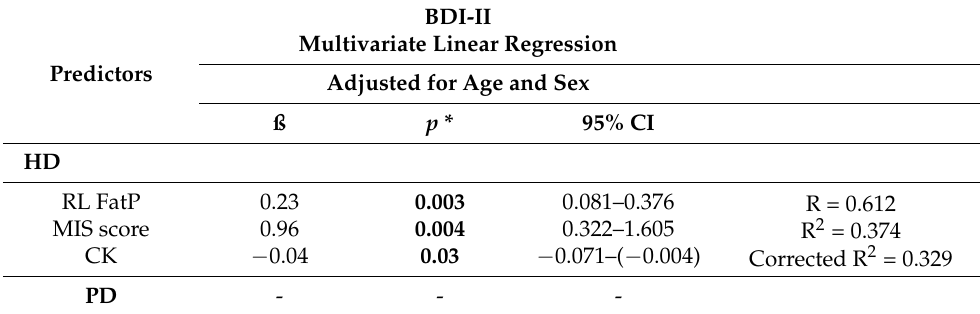
Table 6. Predictors of BDI-II score in HD